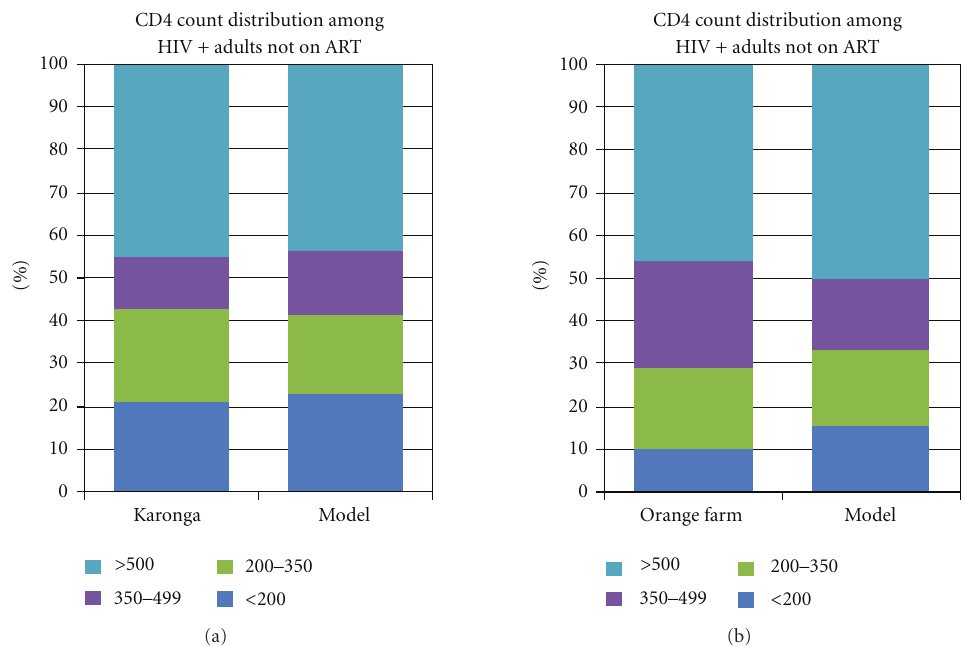
Figure 4: Model results compared to CD4 count distributions for Malawi and South